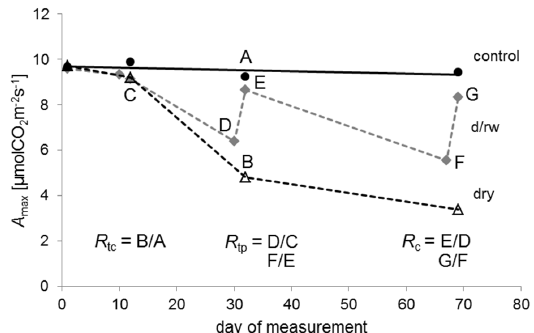
Figure 1. An example of the temporal patterns of the maximum photosynthetic rate ( A max ) for Quercus petraea seedlings of the control (black circles, black solid line), the drying/rewetting (d/rw; grey diamonds, grey dashed line), and the dry group (empty triangles, black dashed line) during the experiment. Resistance in relation to control ( R tc ) is for example the ratio B/A of A max values indicated by the points A and B; resistance in relation to pre ‐ drought conditions ( R tp ) is the ratio D/C or F/E of A max values indicated by the respective points; recovery ( R c ) is the ratio E/D or G/F of A max values indicated by the respective points. Day 1 was the 25 June 2012.